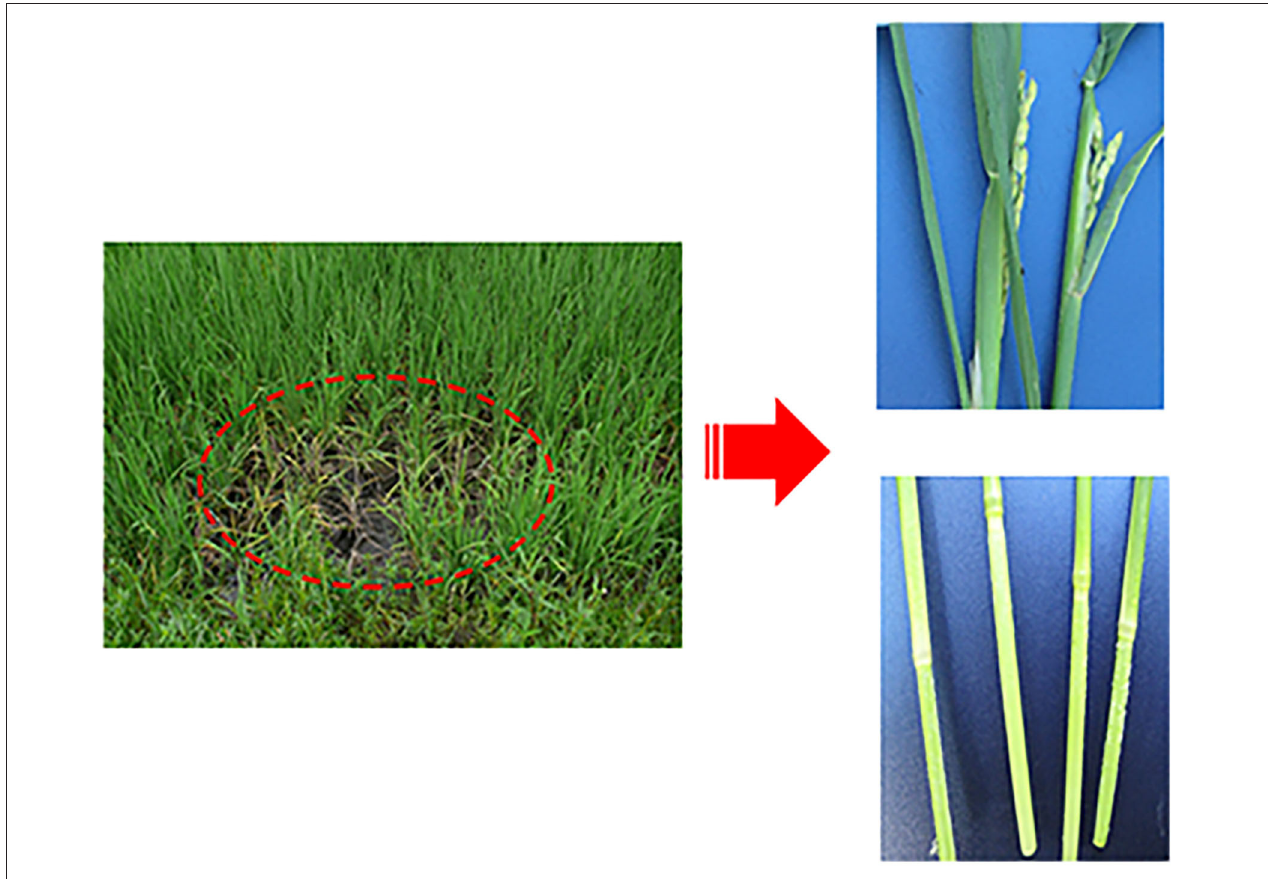
FIGURE 2 | Symptoms of rice infected with SRBSDV. Dashed oval represents rice infected by SRBSDV in the field. The right figures are enlarged symptoms of infected rice leaves (Upper) and stems (Lower) by